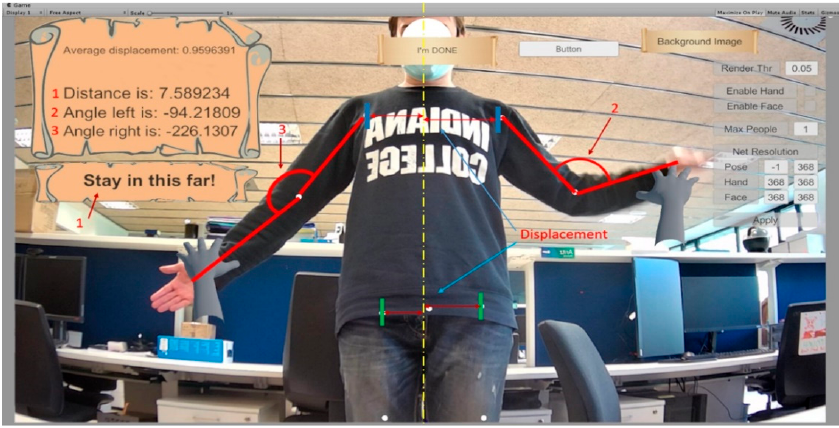
Figure 5. Visual example of activity system parameters.